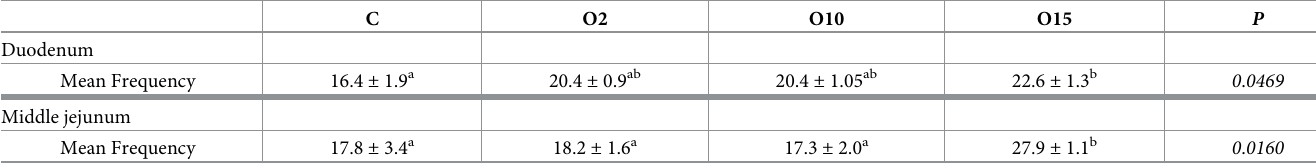
Table 2. The effect of enteral obestatin administration on the frequency of spontaneous contractions [determined as the percentage of response to acetylcholine chloride (10 − 5 M ACh)] in duodenal and middle jejunum strips from piglets. C